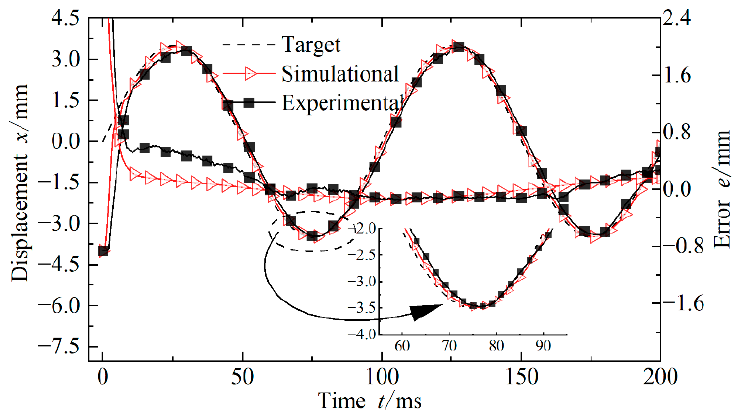
Figure 7. Motion curve of the direct-drive pump piston.